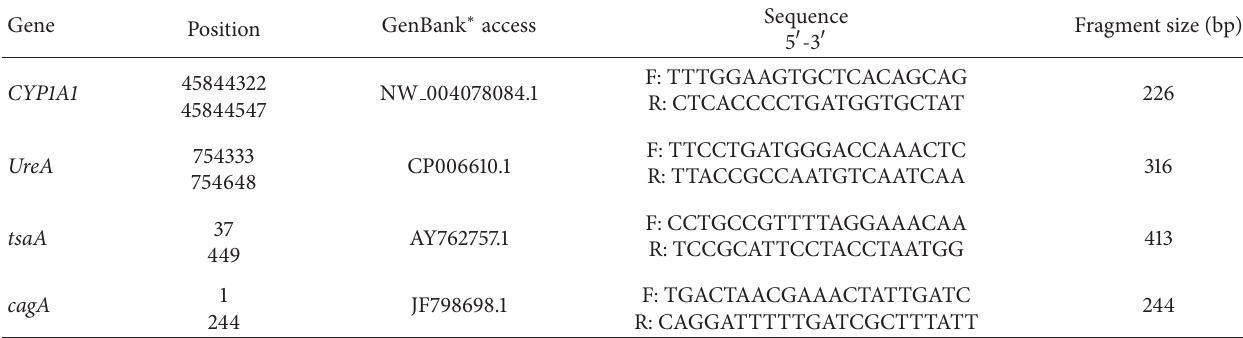
Table 1: Sequence of primers and size of the fragments generated to determine H. pylori infection and cagA genotype.